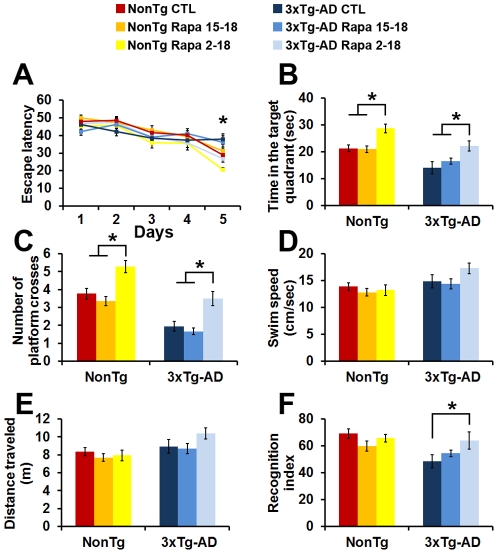
Rapamycin prevents, but does not rescue learning and memory deficits.(A) Mice were evaluated in the spatial reference version of the MWM. Mice significantly learned the task over the 5 days of training, as indicated by a reduced time to find the escape platform (F = 36.2; p<0.0001 as calculated by a mixed-model repeated-measures ANOVA). There was also a significant genotype/treatment-day interaction (F = 2.68; p = 0.021). Bonferroni post hoc analysis showed that the NonTg2–18 mice learned the task significantly quicker than the NonTgCTL mice. In contrast, the NonTg15–18 mice learned as well as the NonTgCTL mice. Similarly, 3 months of rapamycin treatment did not improve learning in the 3xTg-AD mice as the 3xTg-AD15–18 mice performed similarly to the 3xTg-ADCTL mice. In contrast, we found that the 3xTg-AD2–18 mice learned the task significantly quicker than 3xTg-ADCTL mice and as well as NonTgCTL mice. (B–C) Reference memory, measured 24 hours after the last training trials was significantly improved only in the NonTg2–18 and 3xTg-AD2–18 mice compared to the NonTgCTL and 3xTg-ADCTL mice, respectively. Three months of rapamycin administration, however, did not have any effect on reference memory. (D–E) Swimming speed and distance traveled during the probe trials were not significantly different among the 6 groups of mice. (F) Mice were also tested using the object recognition task, a cortical-dependent task. One-way ANOVA showed significant changes in the time mice spent exploring the new object across the 6 different groups (Fig. 2F; p = 0.01). Post-hoc analysis showed that short- and long-term rapamycin treatment had no effect on NonTg mice. In contrast, the 3xTg-AD2–18 mice performed significantly better than the 3xTg-ADCTL mice. Data are presented as means ± SEM.